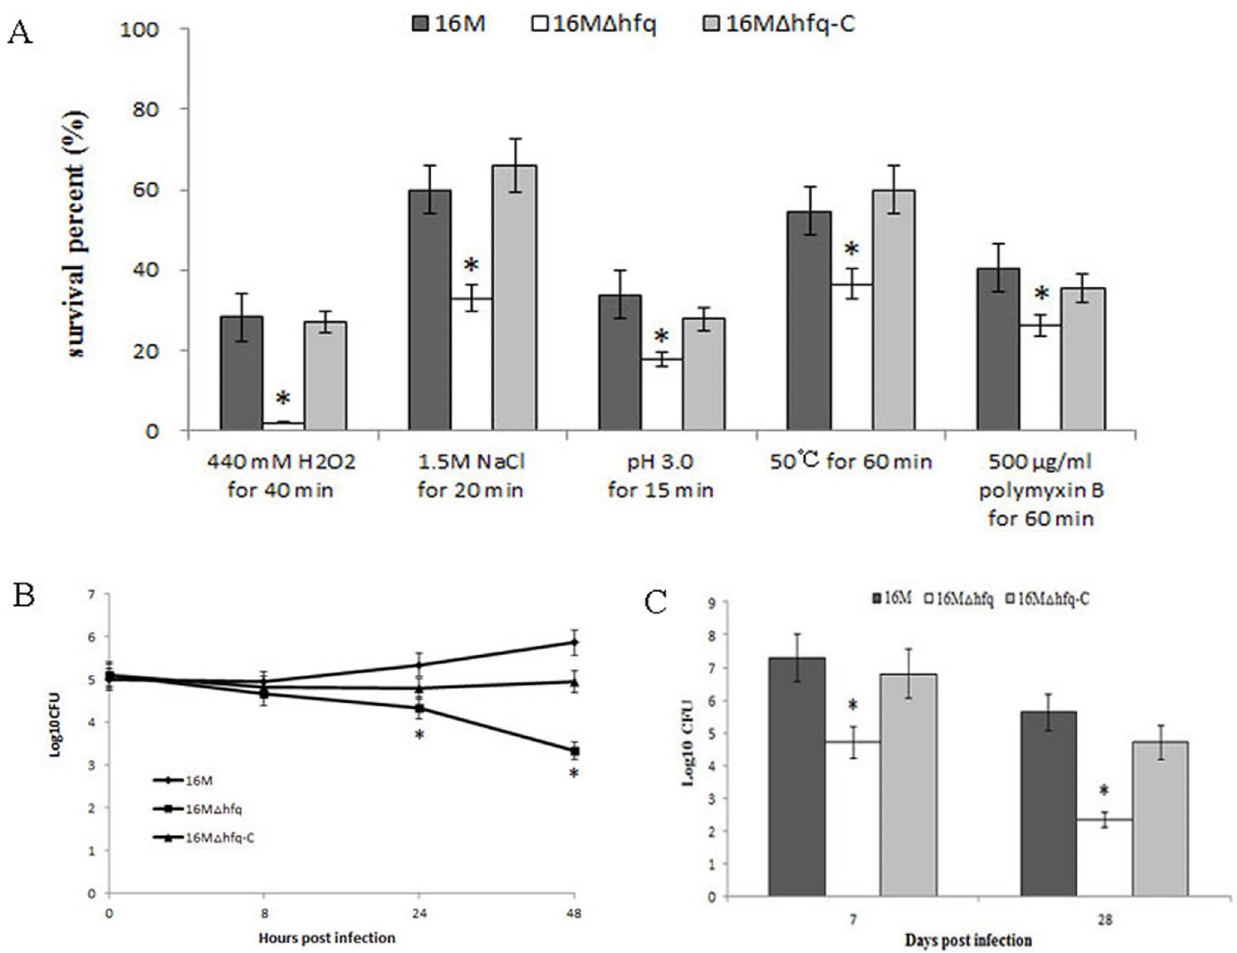
Figure 2. Survival of the B.melitensis D hfq mutant strain in in vitro environmental stress conditions, macrophages, and mice. A. In vitro stress resistance analysis of B. melitensis D hfq mutant strain. 16 M, 16 M D hfq, and 16 M D hfq-C were grown in TSB to the early logarithmic phase and then subjected to different stress conditions as described in the text. After the treatments, the surviving bacteria were enumerated by plating serial dilutions onto TSA plates. Bars represent mean percent survival compared to untreated controls, and error bars represent standard errors of percent survival from 3 replicates. Significant differences between the mutant and parent strain are indicated as follows: *, P , 0.001. B. Survival capacity of B. melitensis D hfq mutant strain in macrophage cells. RAW264.7 cells were infected with strains 16 M, 16 M D hfq, or 16 M D hfq-C at a MOI of 50:1. Three wells were evaluated at each time point for every strain tested, and the colony forming units were determined by serial dilution and plating on TSA. The data was expressed as the mean log 10 CFU 6 SD (n=3). Significant differences between the mutant and parent strain are indicated as follows: *, P , 0.001. C. Survival capacity of B. melitensis D hfq mutant strain in BALB/c mice. Groups of five BALB/c mice were infected intraperitoneally with 1 6 10 7 CFU of 16 M, 16 M D hfq, or 16 M D hfq-C. At 7 and 28 days post-infection, the spleens were aseptically removed and the colony forming units were determined by plating serial dilutions on TSA plates. The data was expressed as the mean log 10 CFU 6 SD (n=5). Significant differences between the mutant and parent strain are indicated as follows: *, P ,